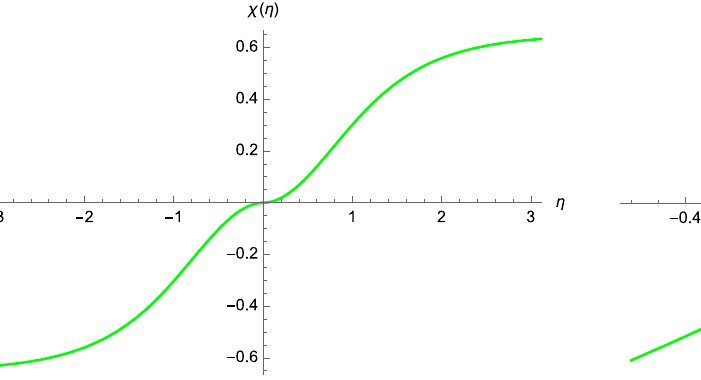
Fig. 5 The function (31) describing the early-time timelike geodesic of the non-comoving observer with t 0 = 0, R = 1, and (cid:23) = 1 and the boundary condition χ( t = 0 ) =